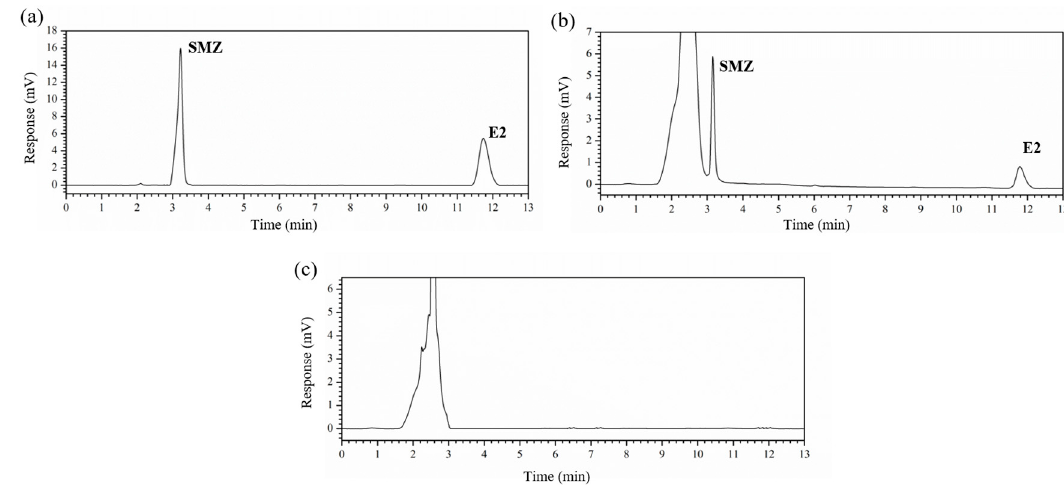
Figure 1. Chromatograms obtained by optimized detection conditions of ( a ) standard solutions of 500 µ g / kg sulfamethoxazole (SMZ) and 17 β -Estradiol (E2) in methanol, ( b ) the extraction solution of the blank soil sample with 20 mg / kg SMZ and E2, and ( c ) the blank soil sample extract.